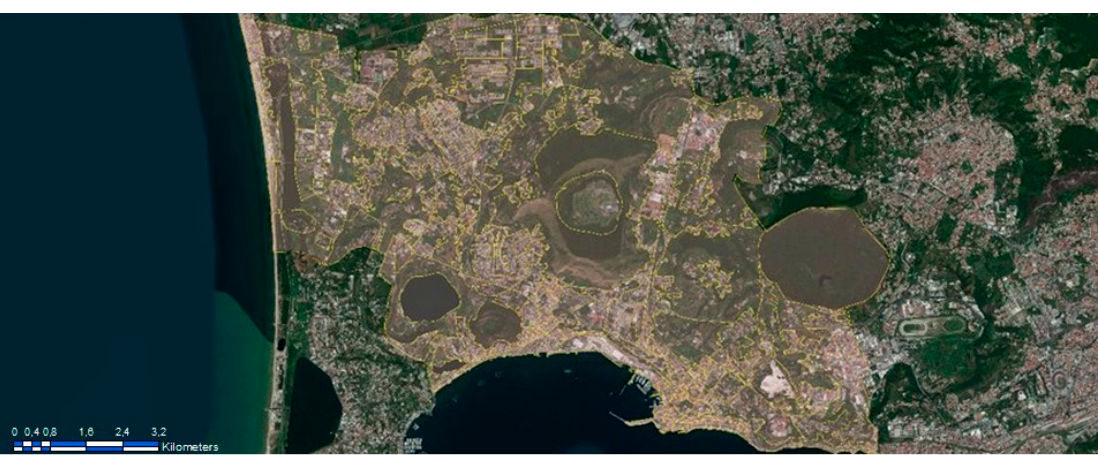
Figure 6. The microzones of the municipality of Pozzuoli.